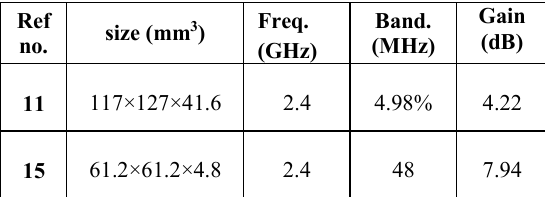
Table 3: Comparison between the proposed antenna and some published antennas